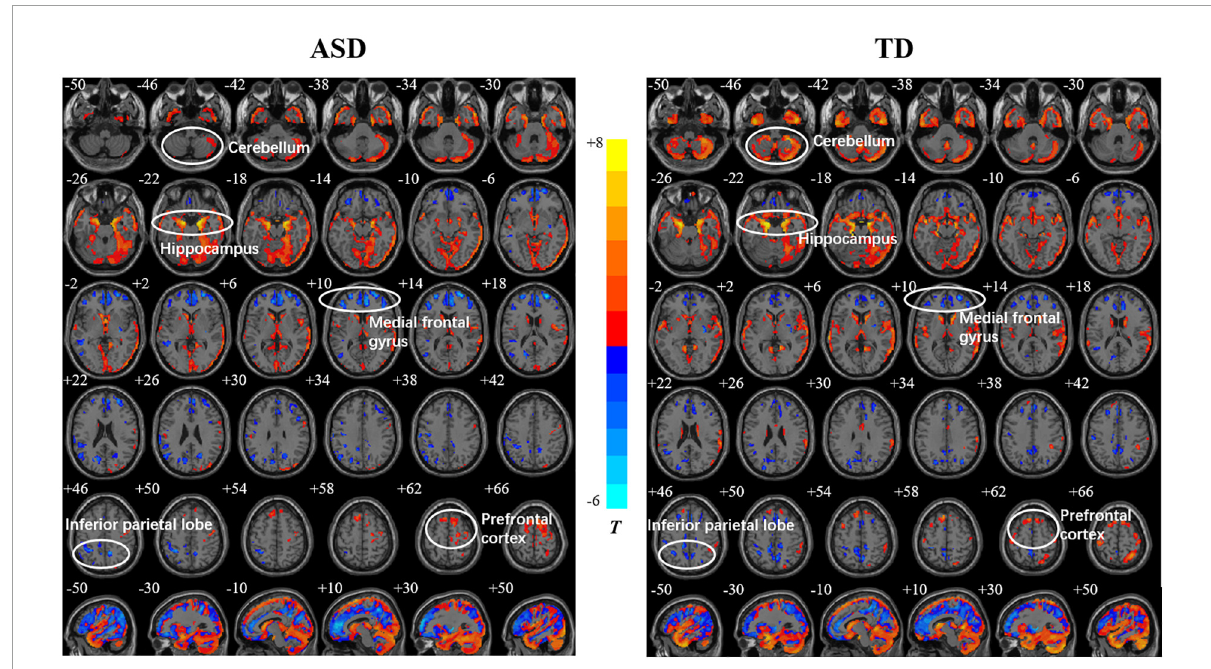
FIGURE1 Relationships between age and gray matter density (GMD) in the autism spectrum disorder (ASD) and typically developing (TD) groups. The color bar shows the T value, in which warm and cold colors represent positive and negative correlations, respectively.